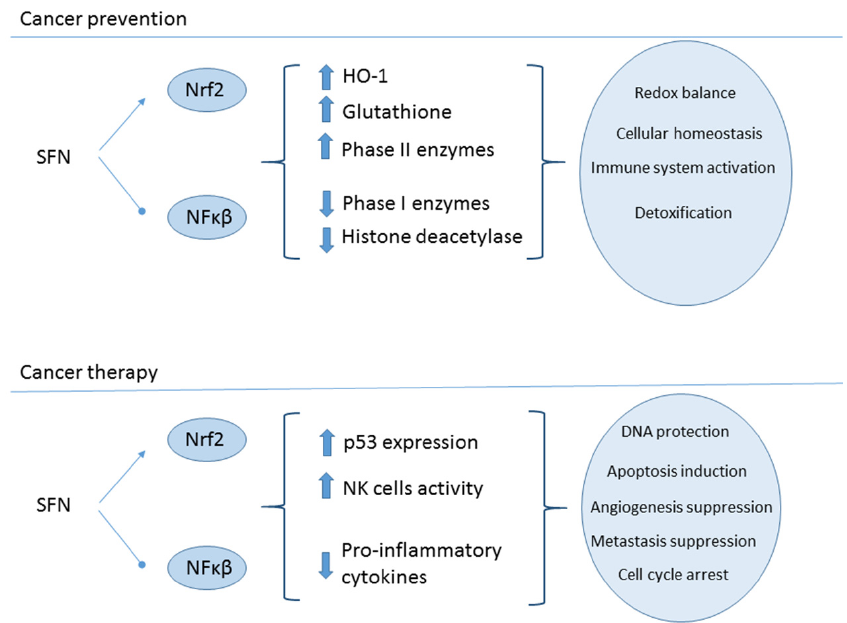
Figure 4. Chemoprotective and chemotherapeutic mechanisms of SFN in cancer cells. SFN exerts chemoprevention by inducing HO-1 and Phase II enzymes, and increasing GSH concentration expression and activating NK cells, as well as downregulating pro-inflammatory cytokines. In both cases, the effect on immune system is mediated by transcription factors Nrf2 and Nf κβ